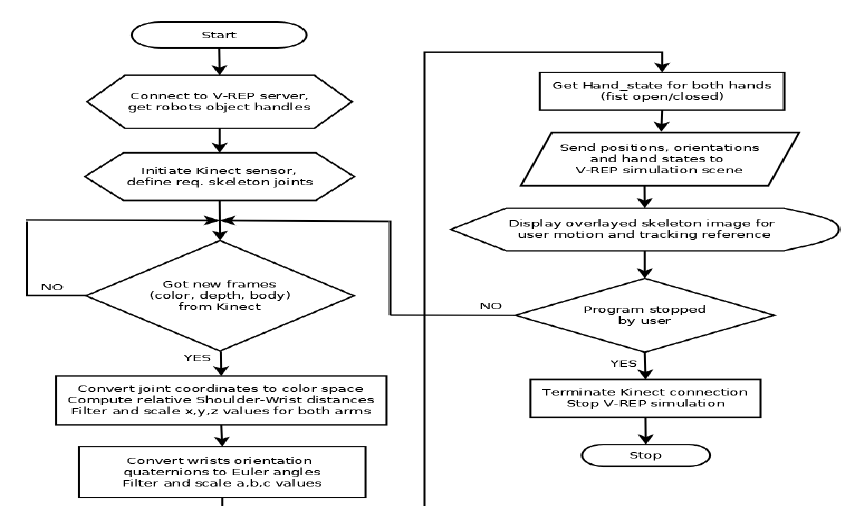
Fig. 7. Simplified flowchart of the Positioning